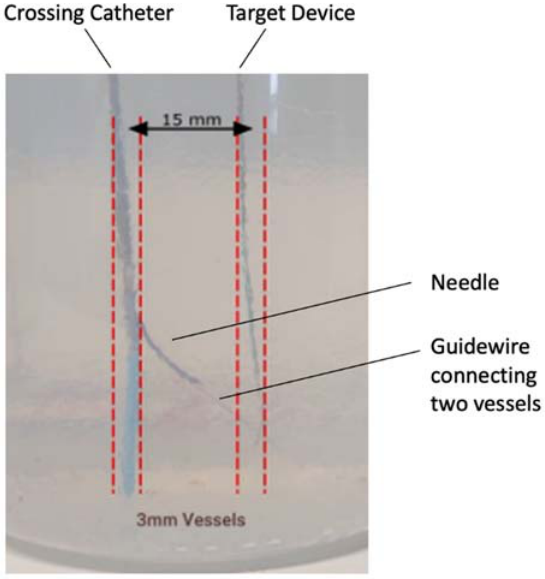
Figure 9. The gel phantom showing the needle deployed and the just discernible guide wire extended in the target vessel.